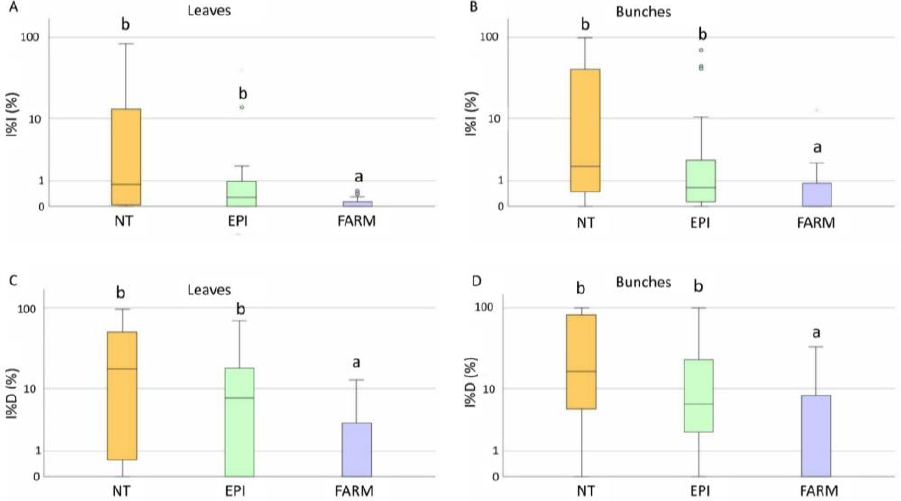
Figure 10. Box plot distribution of the final powdery mildew disease severity (I%I) on leaves ( A ) and bunches ( B ), and incidence (I%D) on leaves ( C ) and bunches ( D ) registered during 2021 in the untreated (NT), EPI (EPI), and farmers’ strategy (FARM) plots. Different letters indicate significant differences among samples ( p < 0.05).